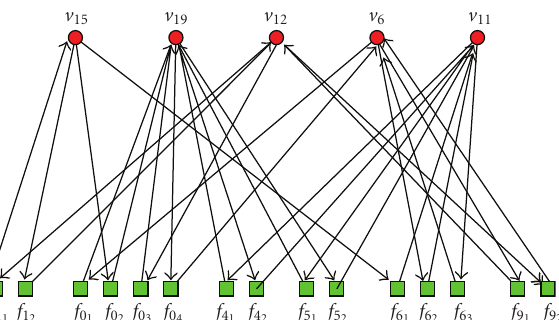
Figure 9: Subgraph of the Tanner graph.